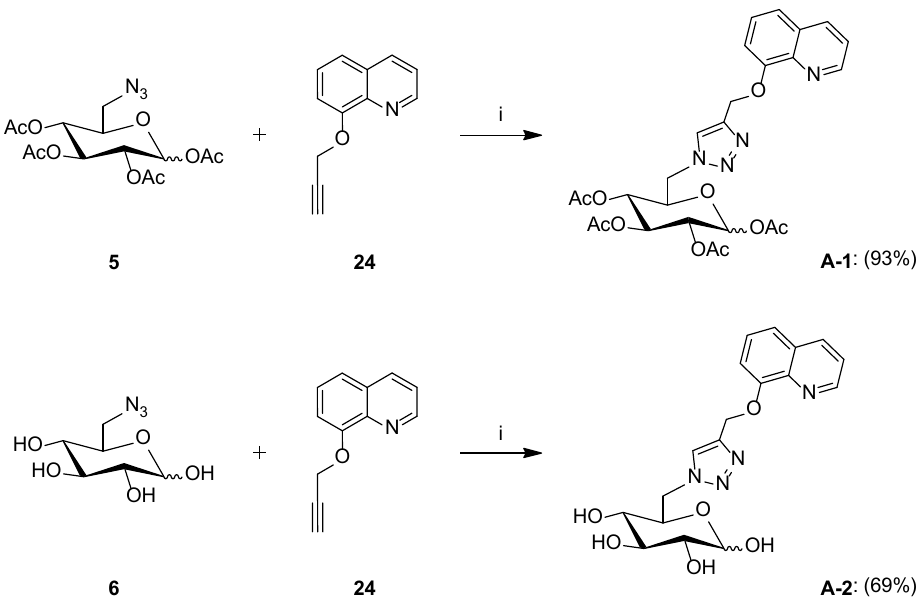
Scheme 5. Synthesis of type A glycoconjugates. Reagents and Conditions: ( i ) CuSO 4 · 5H 2 O,